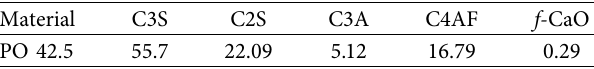
Table 3: Mineral composition of main raw materials (in percentage).